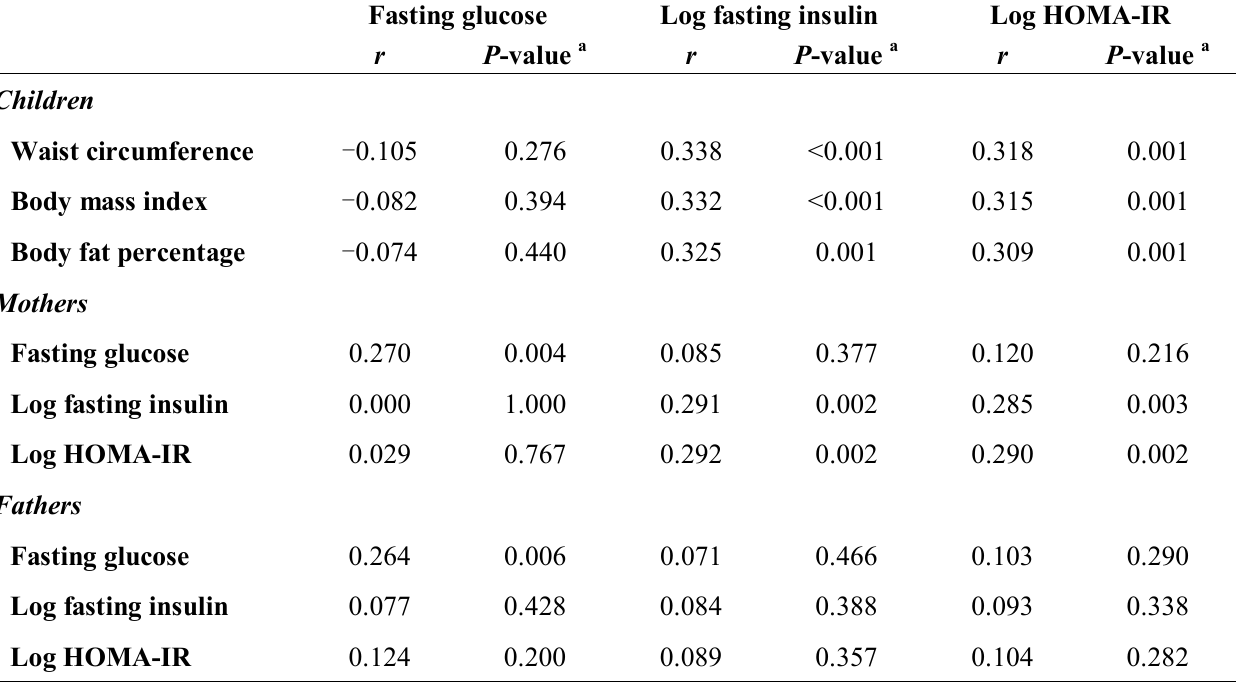
Table 3. Sex-adjusted partial correlation coefficients between indices of glucose metabolism, and adiposity indices of children and glucose metabolism of their